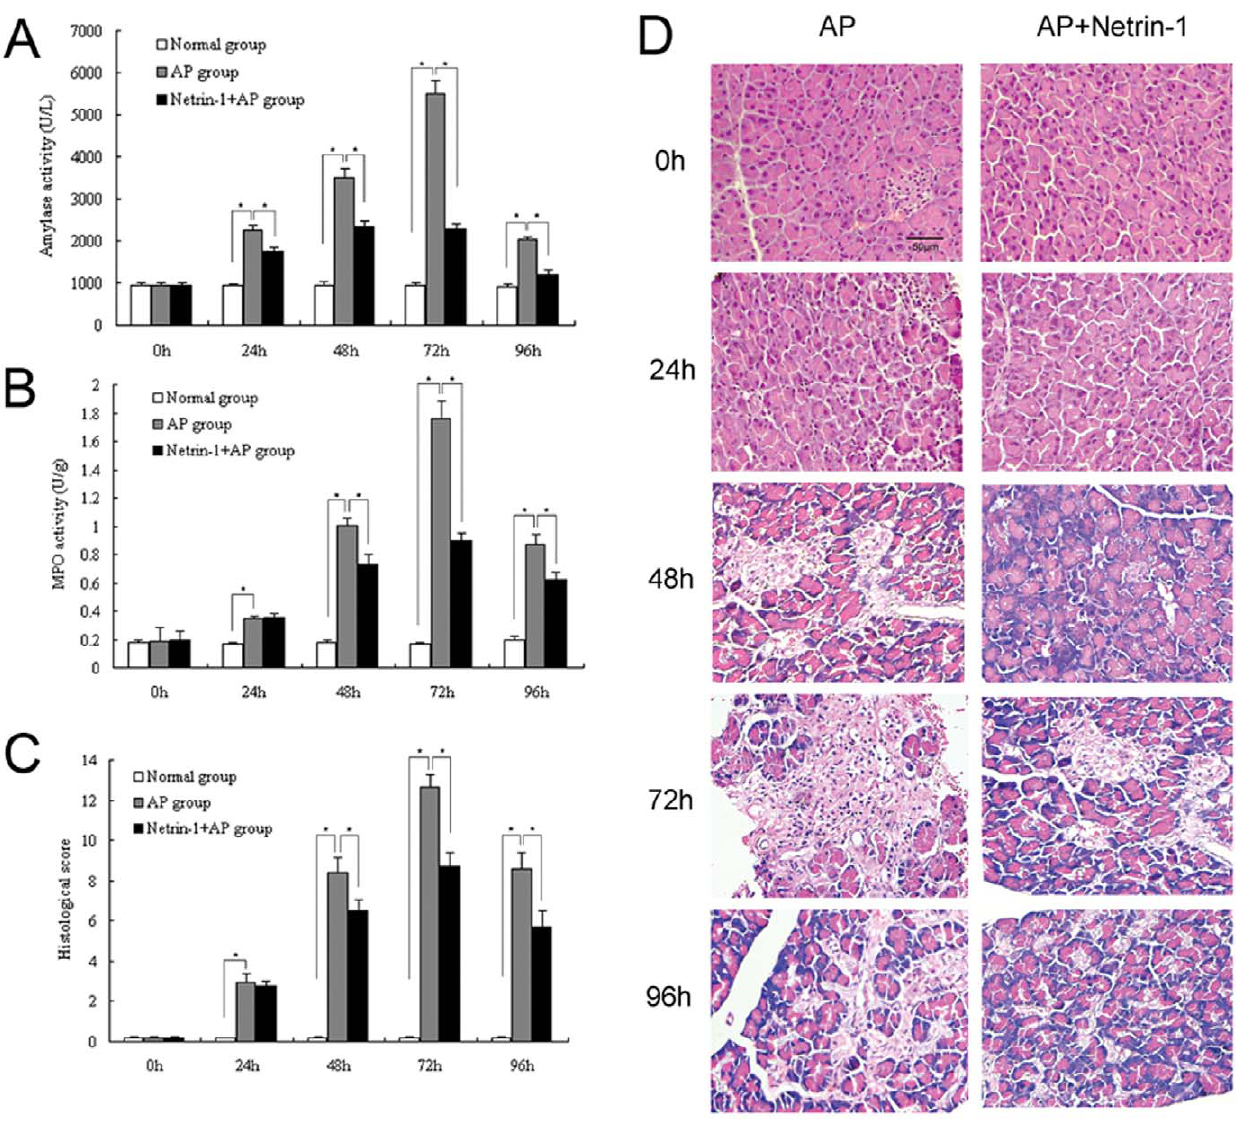
Figure 2. Effect of netrin-1 on pancreatic inflammation. A. Plasma amylase activity. B. Pancreatic myeloperoxidase (MPO) activity. C. Histological scores (sum of interstitial edema, inflammatory cell infiltration, hemorrhage, and acinar cell necrosis). D. Histology. Representative micrographs of H&E-stained pancreatic sections at the indicated times are shown. Acute pancreatitis was induced by 2-hourly two intraperitoneal injections of L-Arginine (4 g/kg, 1 h apart). Mice were treated with recombinant mouse netrin-1 at a dose of 1 m g/mouse or vehicle (0.1%